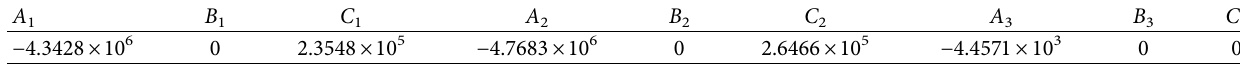
Table 2: Stress coefficients under internal pressure.